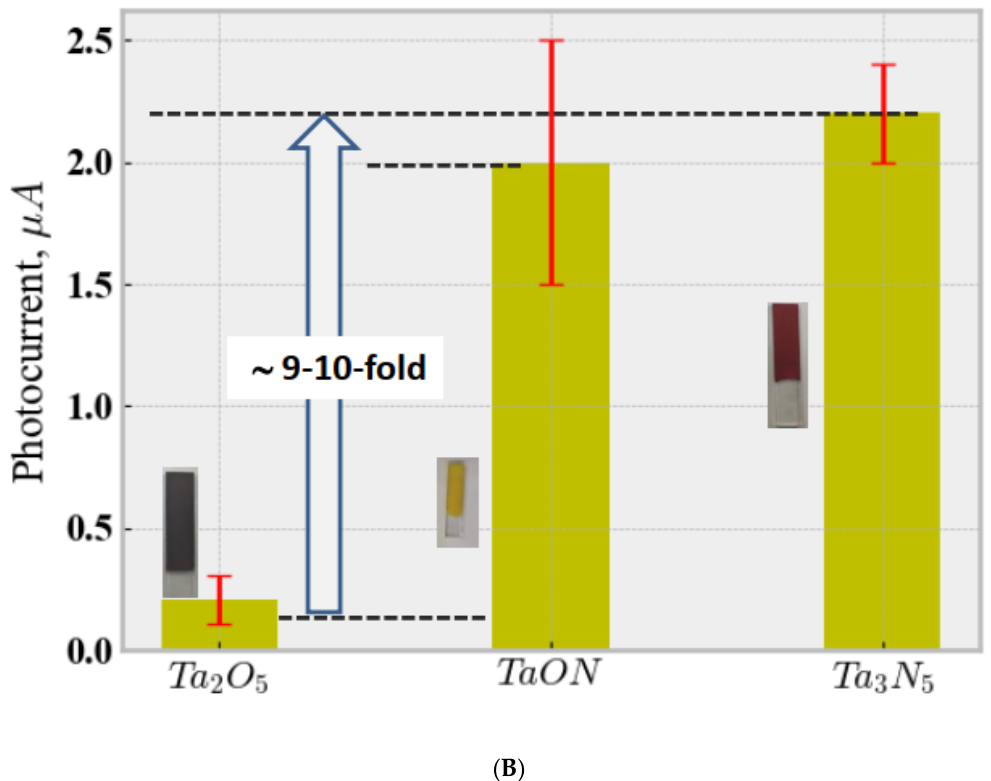
Figure 6. ( A ) The chronoamperometry (i/t) responses for the as-synthesized Ta 2 O 5 and Ta 3 N 5 samples. (Operating conditions: Pt counter electrode, leak-free Ag/AgCl (in 0.2M NaOH) as the reference electrode and sample coated ITO slide as a working electrode. Light intensity: 80 mW/cm 2 , applied potential μM). ( B ) Photocurrent responses from Ta 2 O 5 and its subsequent nitrogen derivatives. The error bars represent the range obtained with different films. (Operating conditions: Pt counter electrode, leak-free Ag/AgCl (in 0.2M NaOH) as the reference electrode and sample coated ITO slide as a working electrode. Light intensity: 80 mW/cm 2 , no external bias applied).